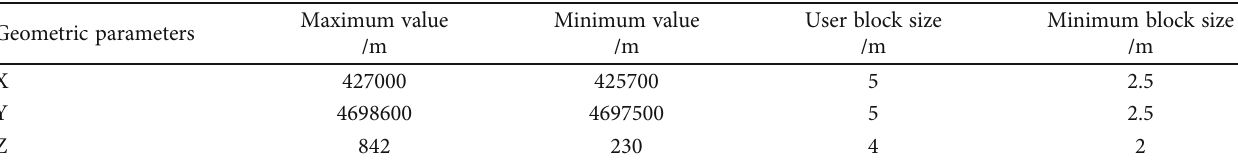
Table 5: Block model geometry parameters.